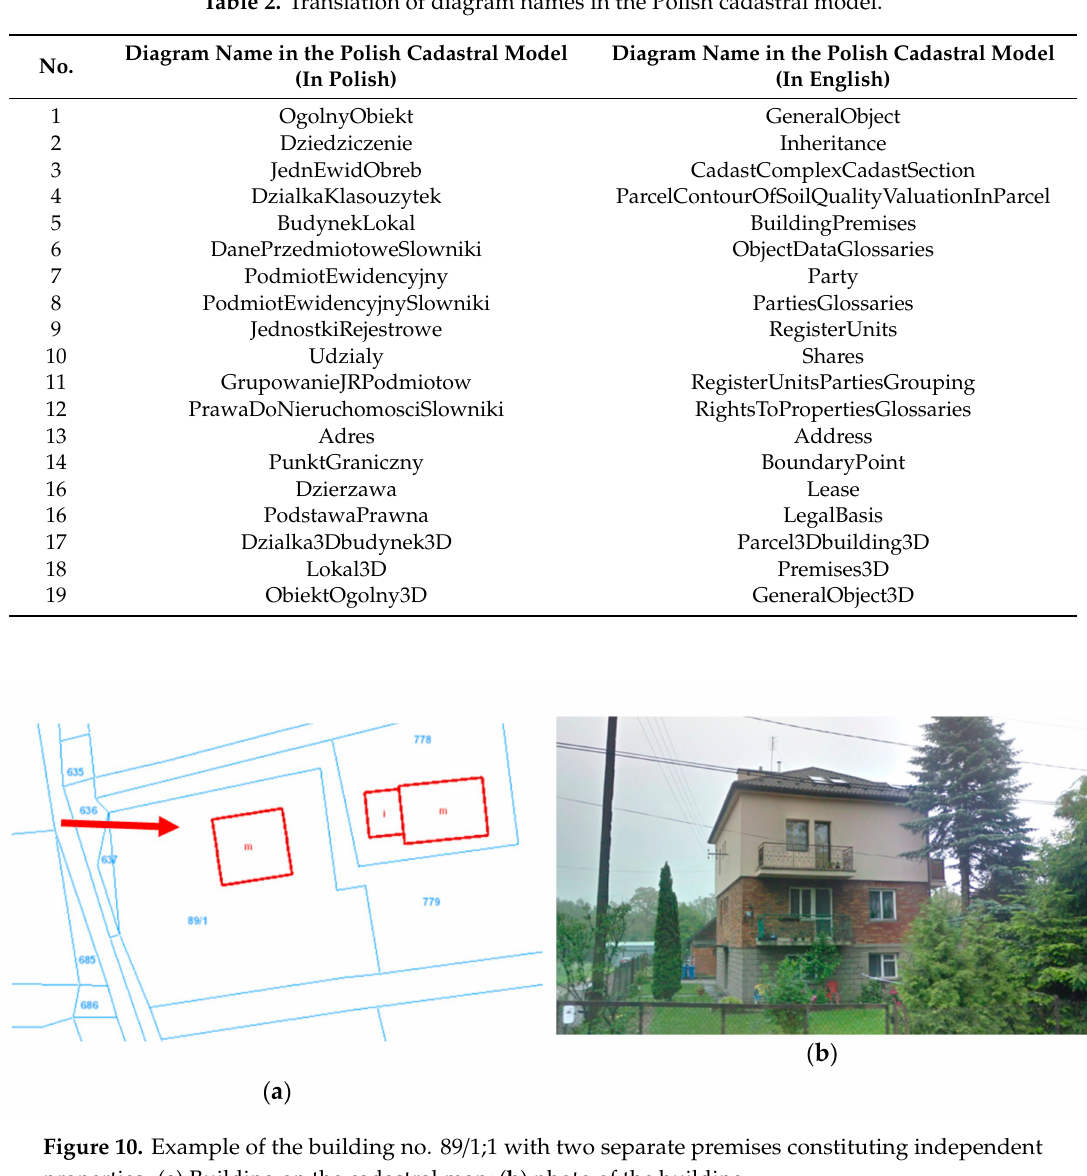
Table 2. Translation of diagram names in the Polish cadastral model.